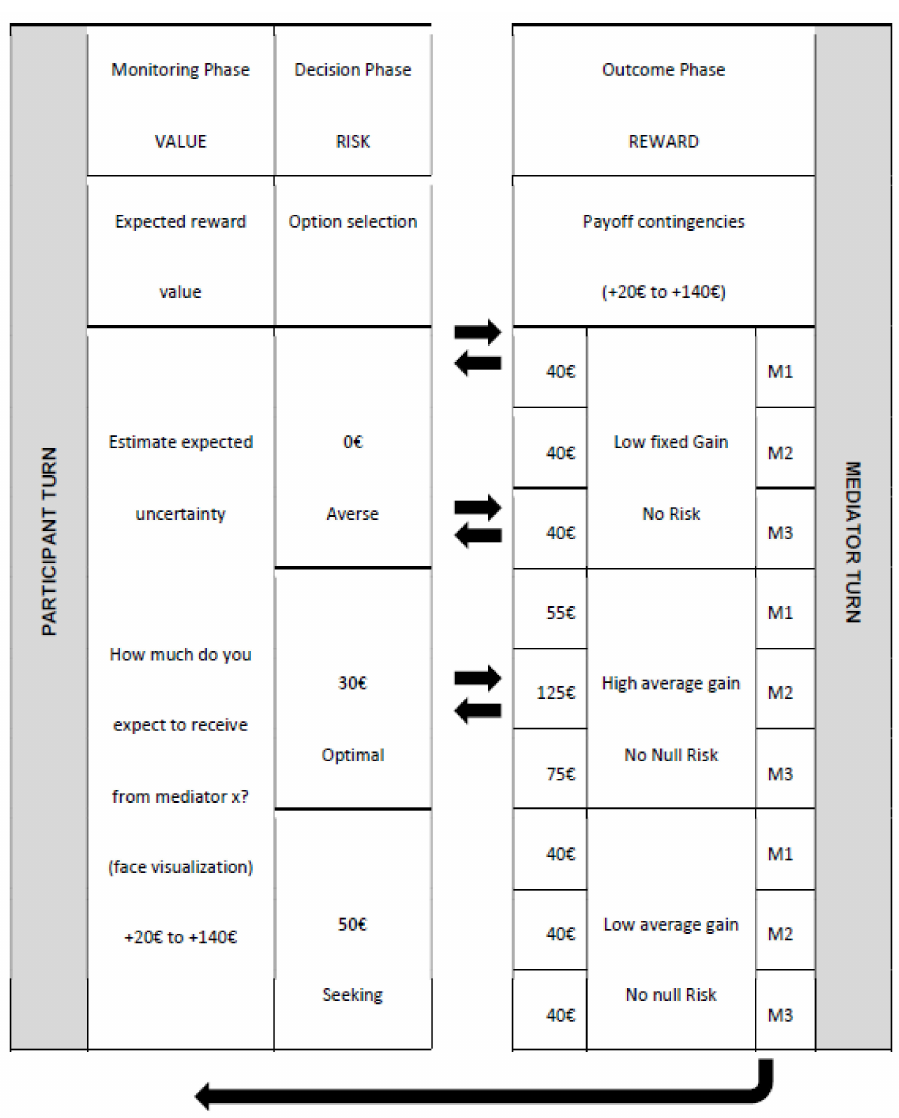
Figure 1. Example of economic experimental design considering a run sequence in trustor-trustee interaction. M0—the non-human mediator—has the same reward contingencies as M1. For details see